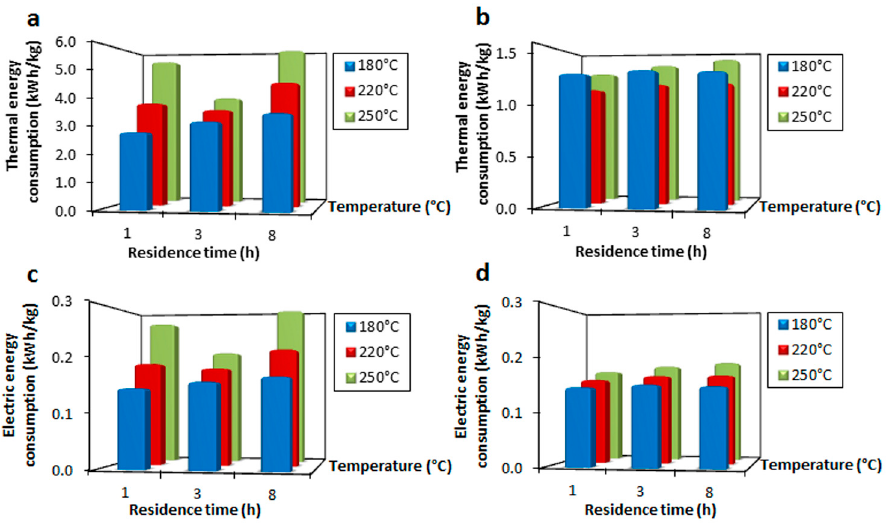
Figure 3. Specific energy consumption (kWh/kg hydrochar ) at different HTC temperatures (180, 220, 250 °C) and residence times (1, 3, 8 h): ( a ) thermal energy for OSC; ( b ) thermal energy for GM; ( c ) electric energy for OSC; ( d ) electric energy for GM.